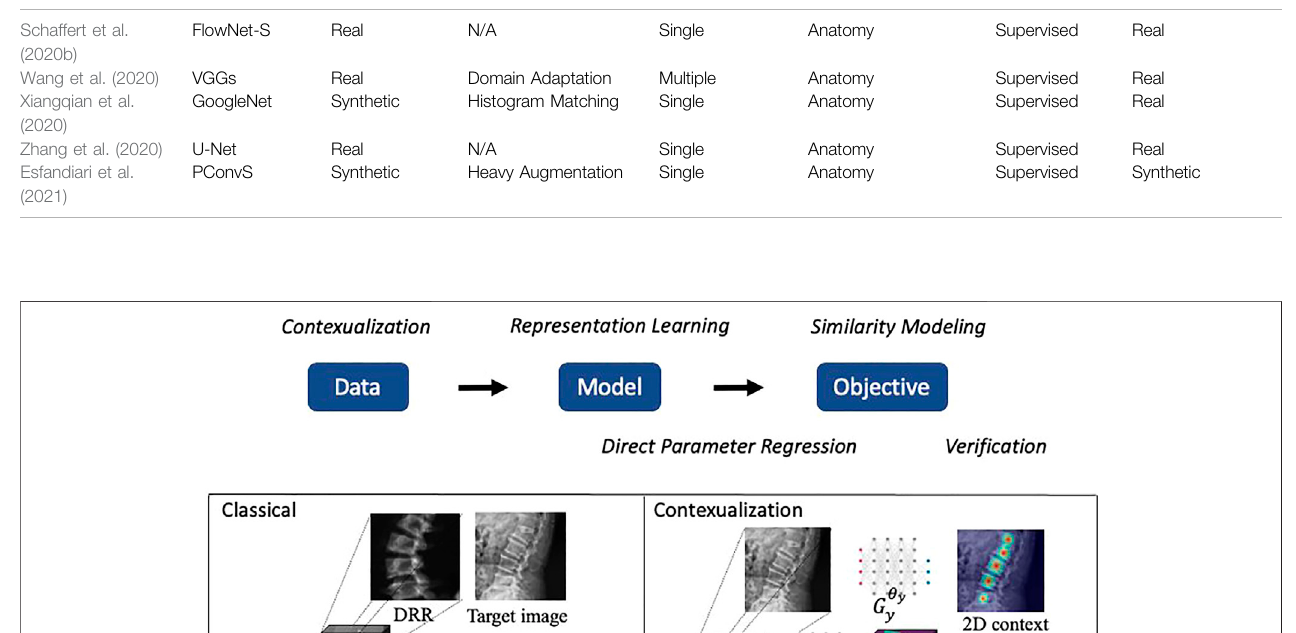
Frontiers in Robotics and AI |